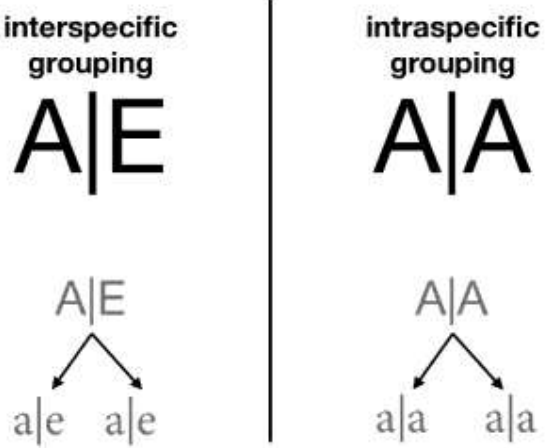
Figure 1. Class of associations. Chart of the type of associations among digital organisms. A and E are organisms with their offspring (a and e, respectively). The arrows indicate the direction in which the resources are delivered.